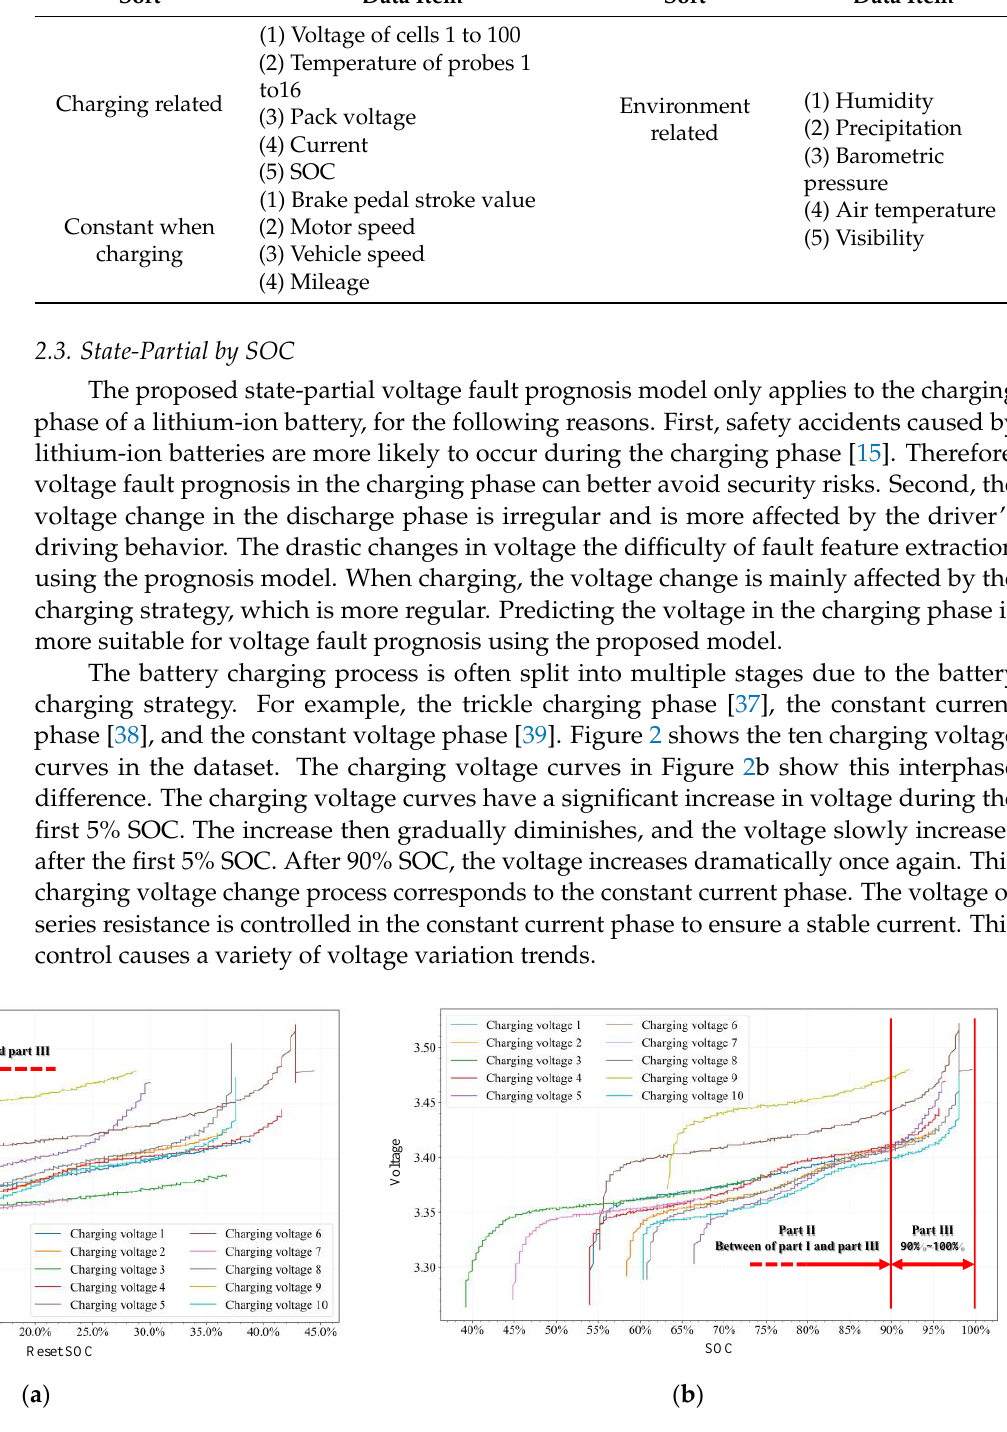
Figure 2. Charging voltage curves: ( a ) charging voltage curves after resetting the SOC; ( b ) original charging voltage curves.